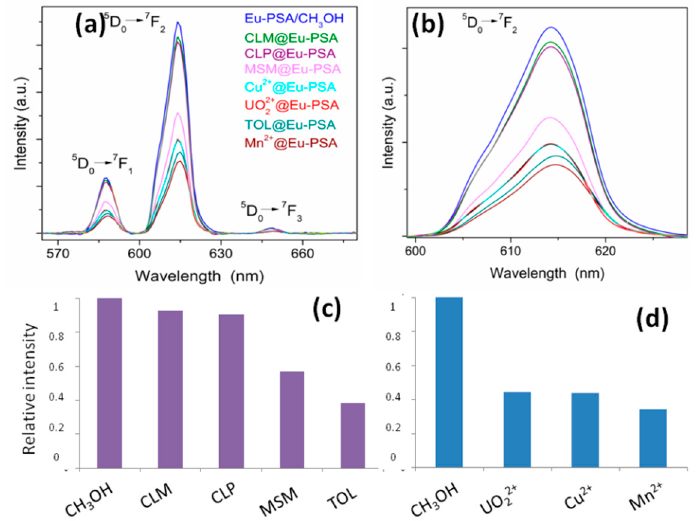
Figure 6. ( a ) Emission spectra of Eu-PSA under diverse pollutant exposition (concentration = 2 × 10 − 3 M). ( b ) Zoomed region of the Eu 3+ hypersensitive 5 D 0 → 7 F 2 transition. ( c ) Relative intensities of the hypersensitive signal of Eu-PSA (down) in the presence of organic and ( d ) inorganic pollutants.